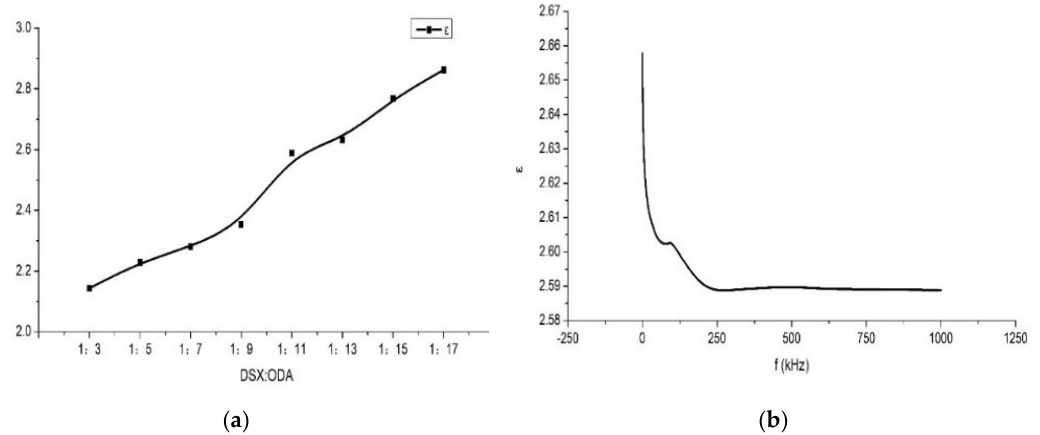
Figure 5. Permittivity curves of group 1, and ε represents the dielectric constant. ( a ) At 1 MHz, the change curve of dielectric constant with DSX/ODA ratio. ( b ) When the ratio of diamines was 1:11, change curve of the dielectric constant (Dk) with frequency.